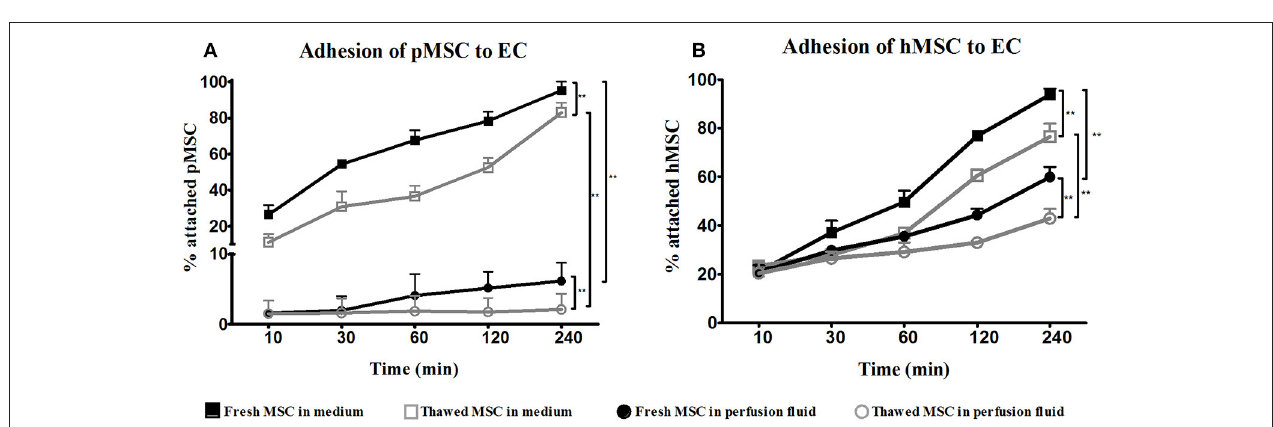
FIGURE 2 | Adhesion of fresh and cryopreserved pMSC and hMSC to EC in medium and perfusion fluid. (A) pMSC attachment to PAOEC over time in culture medium. pMSC show reduced binding to PAOEC in perfusion fluid. Thawed pMSC showed a further reduced ability to bind to EC in perfusion fluid. (B) Thawed hMSC showed reduced attachment to HUVEC compared to fresh hMSC either in culture medium or perfusion fluid ( n = 5). Results are shown as means ± SD. ** p <